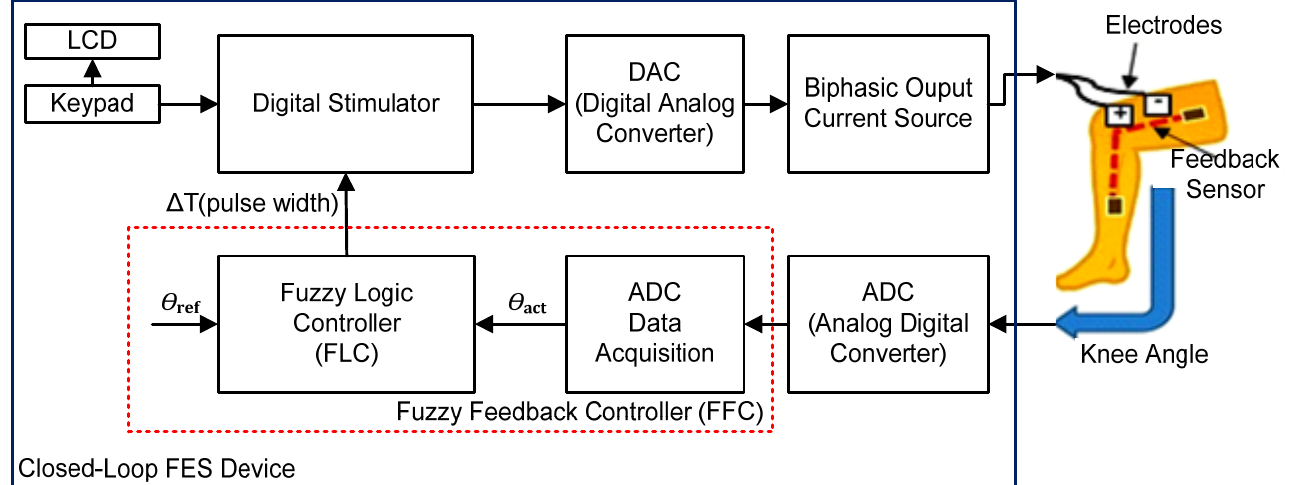
Figure 1. System overview of closed-loop functional electrical stimulation (FES).